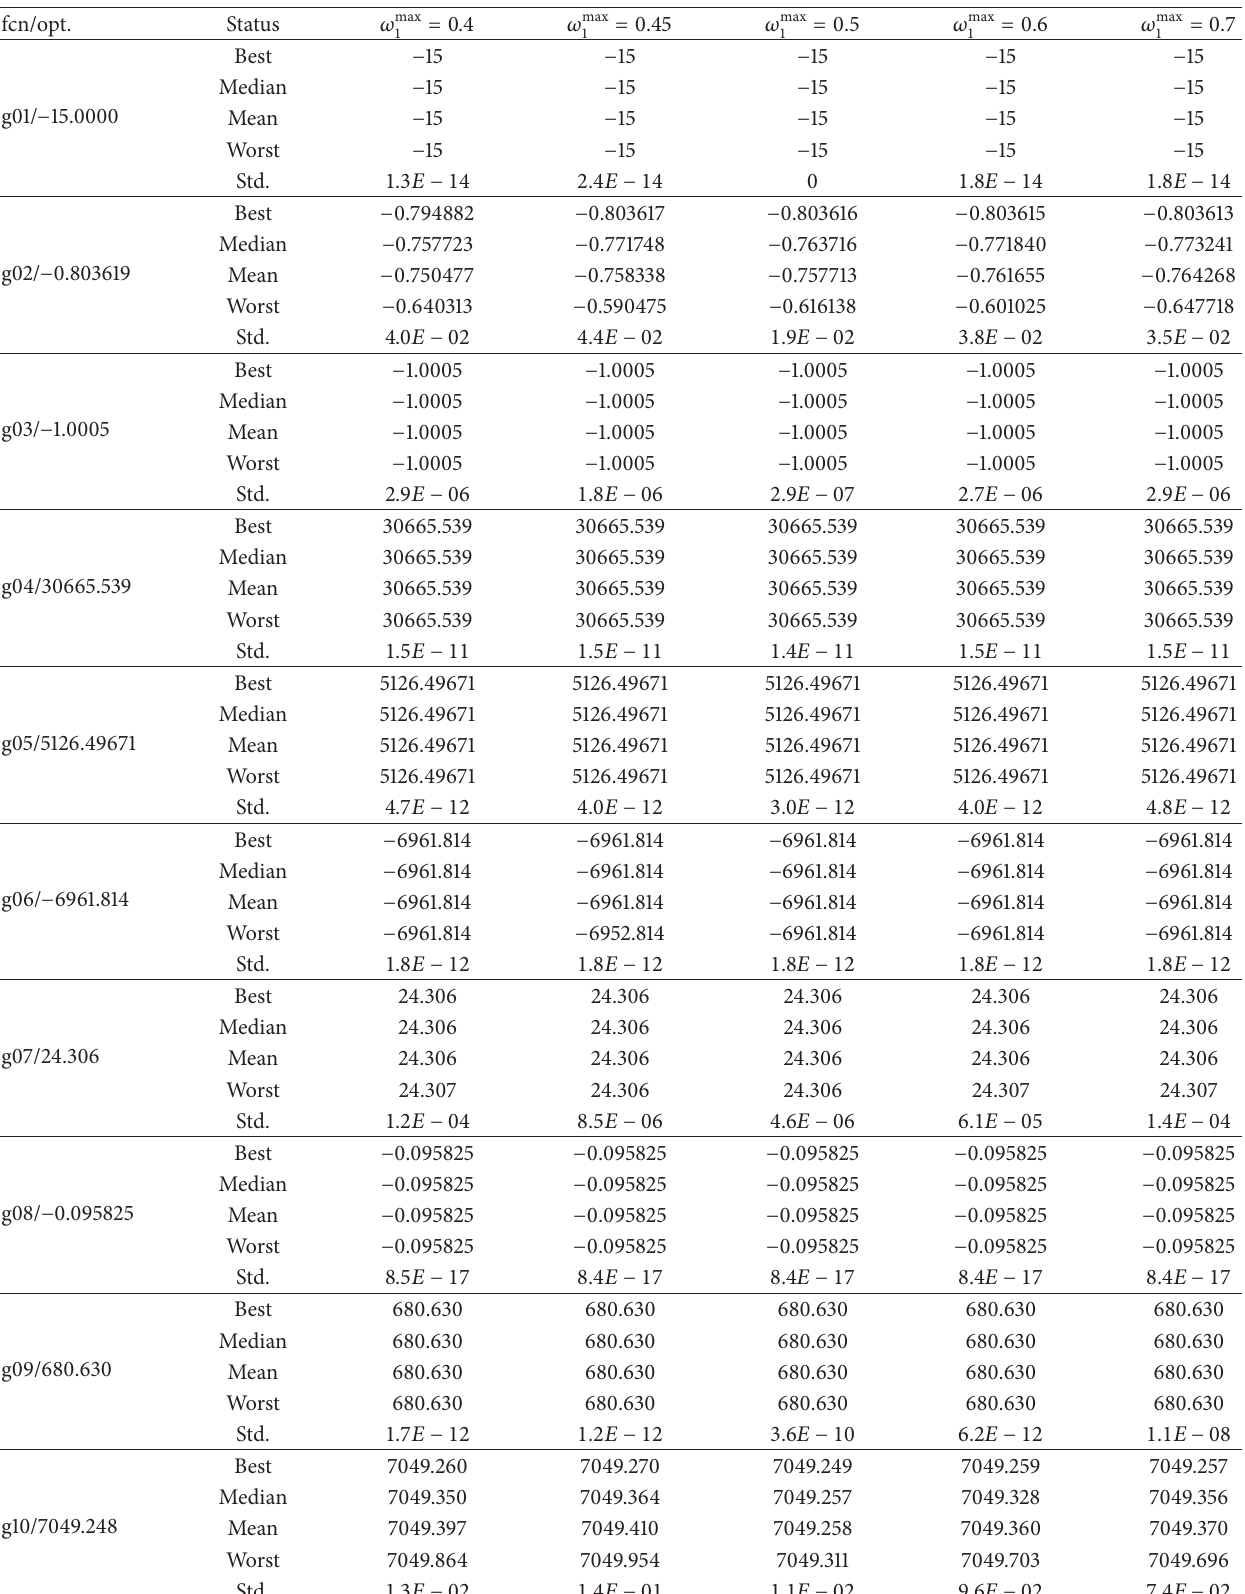
Table 6: Statistical results obtained by MDE-DP over 30 independent runs with different upper bound values of the first component in weighting vector 𝜔 in stage